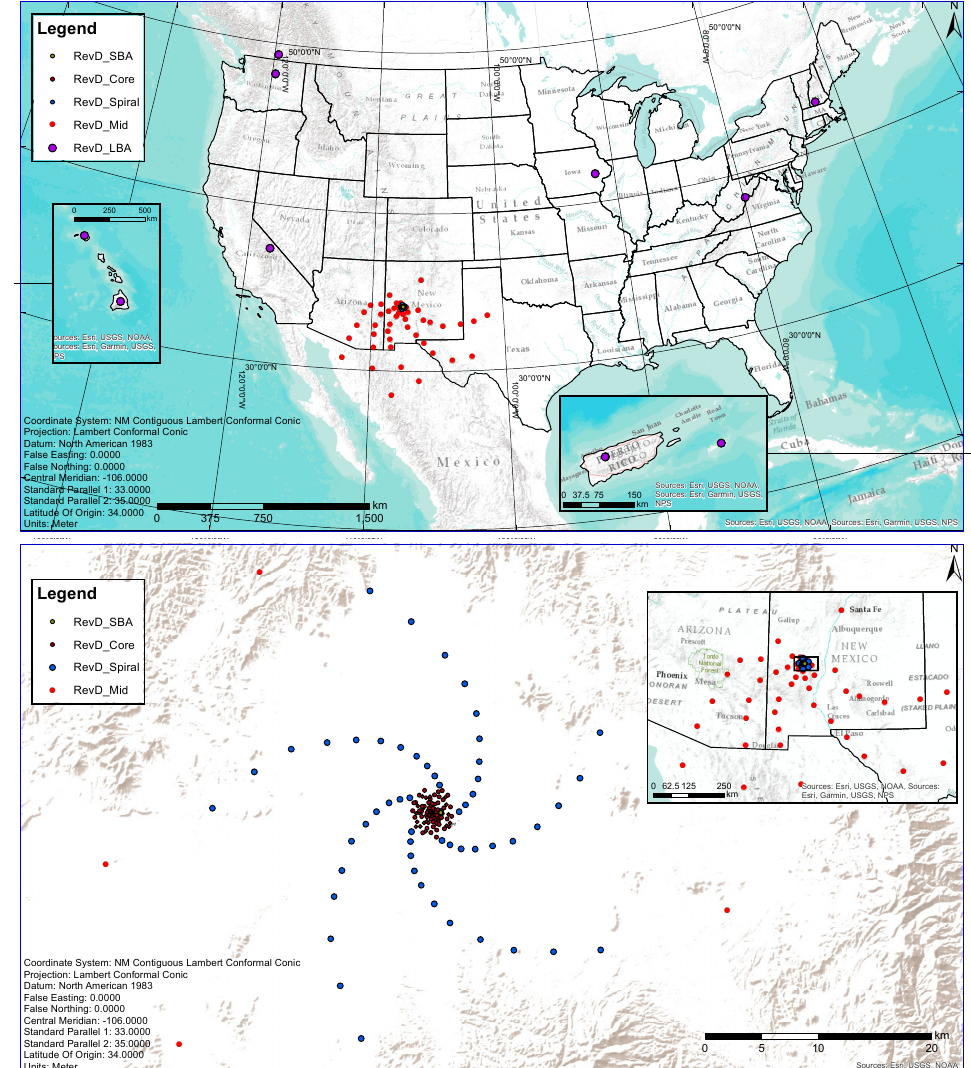
Figure 2. ( Top ): A potential configuration layout for the ngVLA showing all 263 antennas spread across the North American Continent. The Array is centered at the current VLA site on the plains of San Agustin in New Mexico. The legend associates each antenna with a logistical sub-component of the full array. Each of the long-baseline stations (purple dots) consists of 3 antennas. ( Bottom ): A zoom-in of the main array showing the five-arm spiral pattern (54 18 m antennas) and dense core (114 18m antennas). The maximum baseline of the spiral and core antennas is 29.3 and 4.3km, respectively. The 19 6m SBA antennas are located within the central